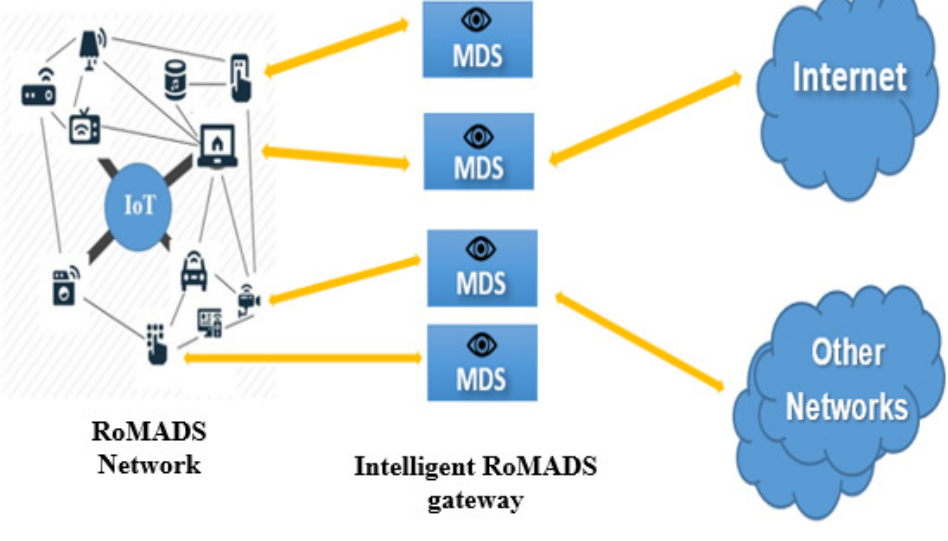
Figure 12. Intelligent RoMADS gateway.